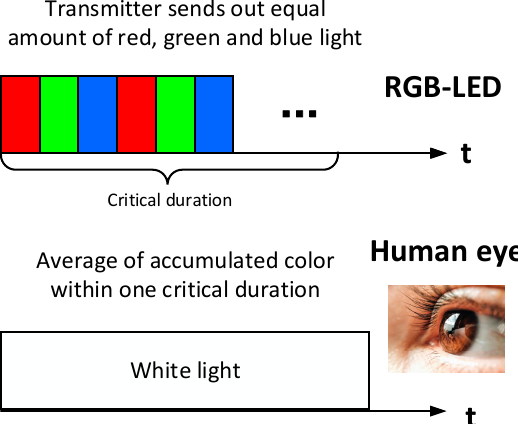
Figure 2. Average color perceived by the eye in a critical duration.